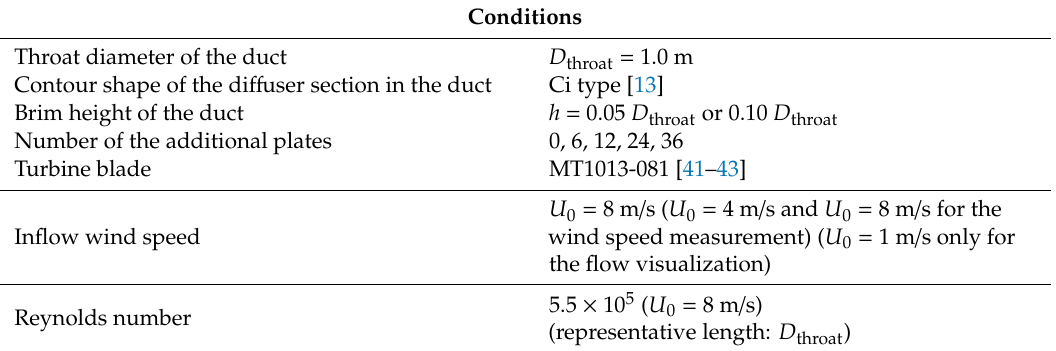
Figure 5. Additional plates installed on WLT for the purpose of stabilizing vortices around the brim: ( a ) Four various shapes of the plates (Thick lines pink and purple indicate diffuser contours); ( b ) In situ photograph of the plates on the WLT (twelve plates type 2, h = 0.05 D throat ). Table 1. Experimental materials and wind tunnel settings.